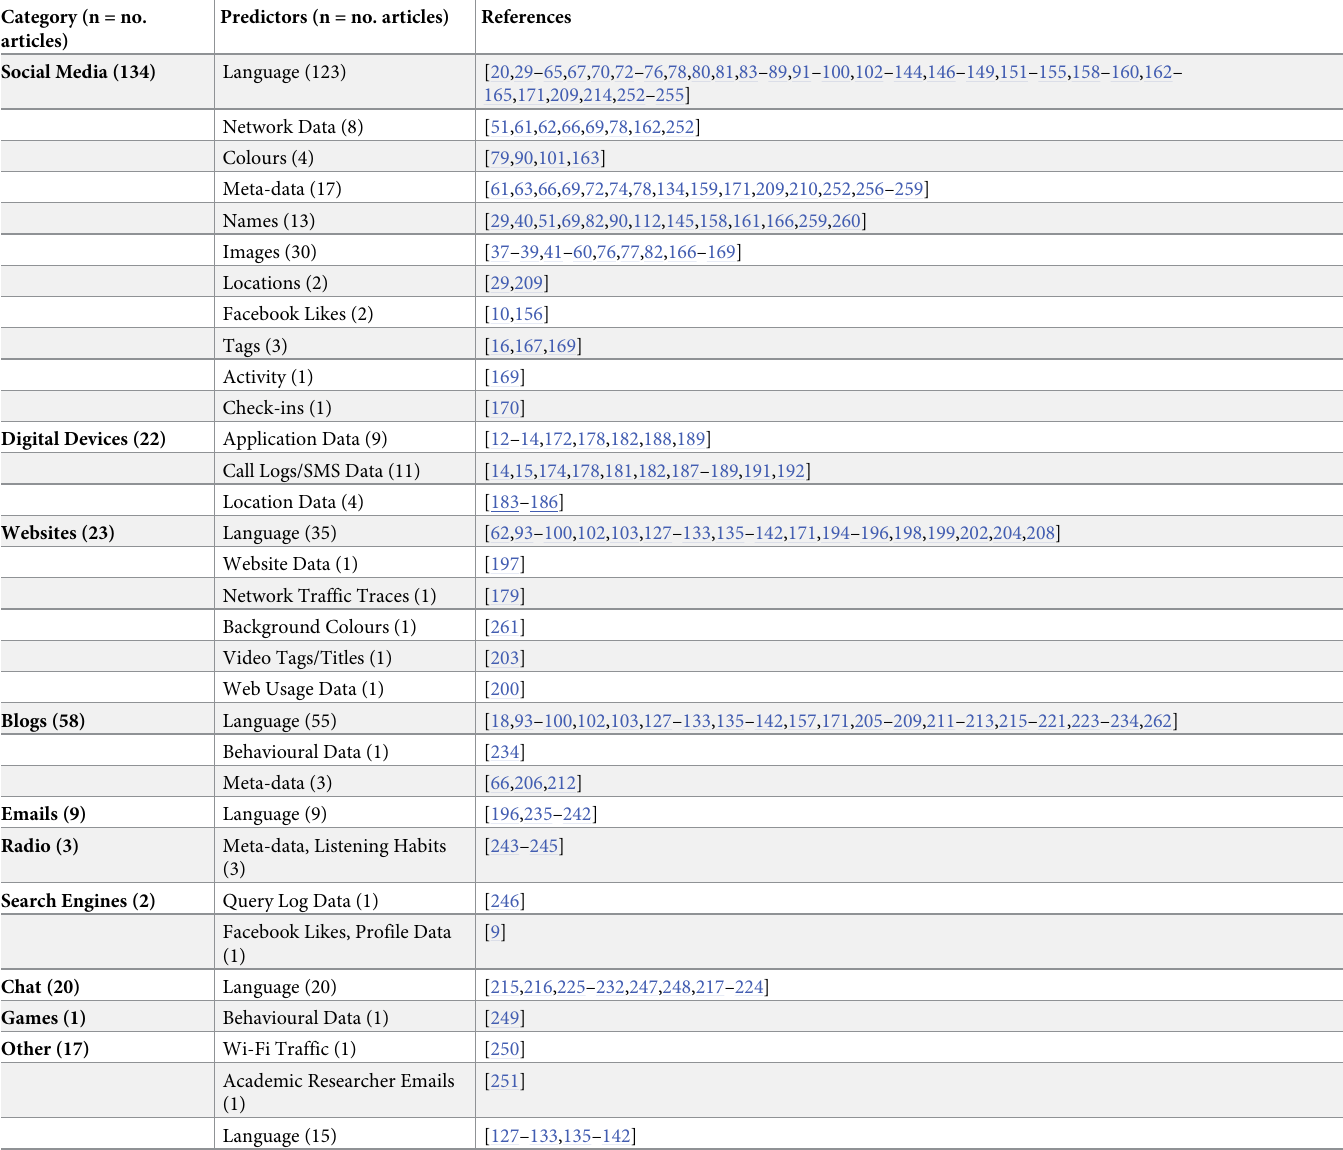
Table 2. Number of articles predicting gender, with associated predictors and references. Category (n = no. Predictors (n = no. articles)